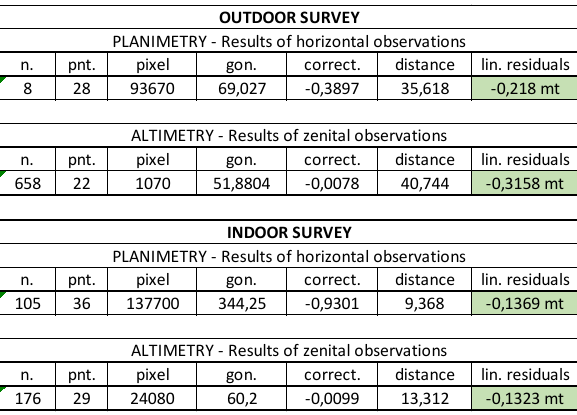
Figure 6. Residuals of linear errors after the orientation network Afterwards, details were modelled on the main minaret body in correspondence with the image projections using the mono- plotting. The solid 3D model can be drafted after an accurate operation of editing, representing a starting point for the BIM representation. (Fig. 7)